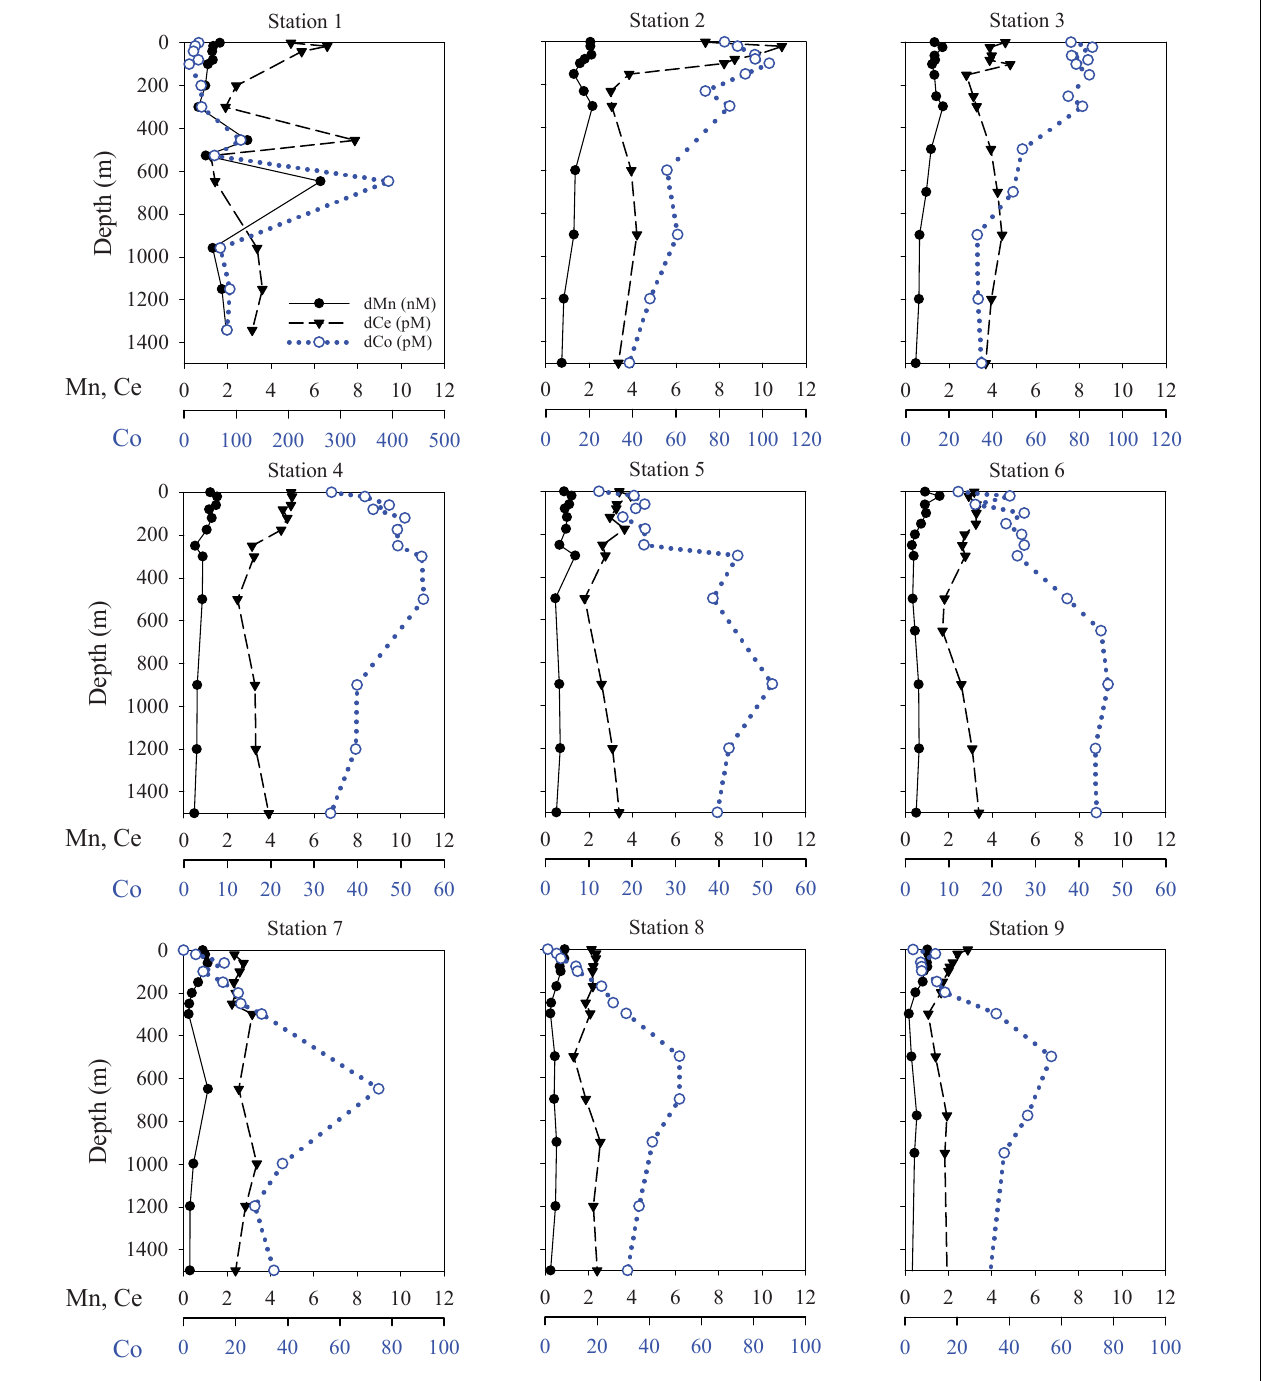
FIGURE 6 | Vertical properties of dissolved trace elements: Vertical profiles of dissolved Mn (nM), Co (pM), and Ce (pM). Note that Co concentration (in blue) scales change depending on the ranges encountered at each station.